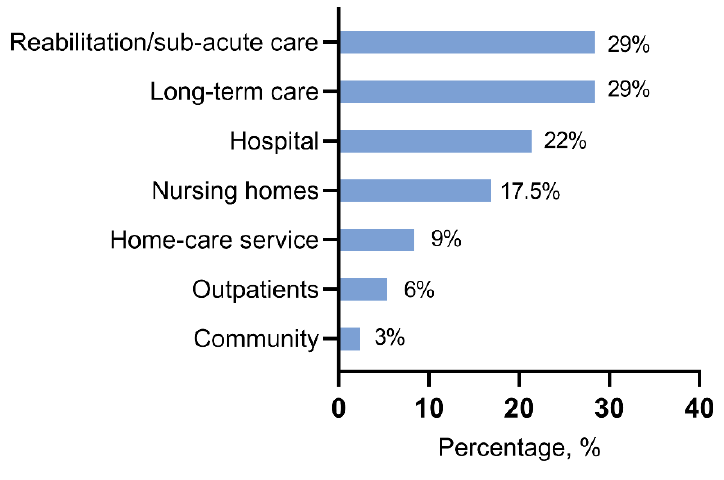
Figure 1. Prevalence of malnutrition based on the setting of care [27].